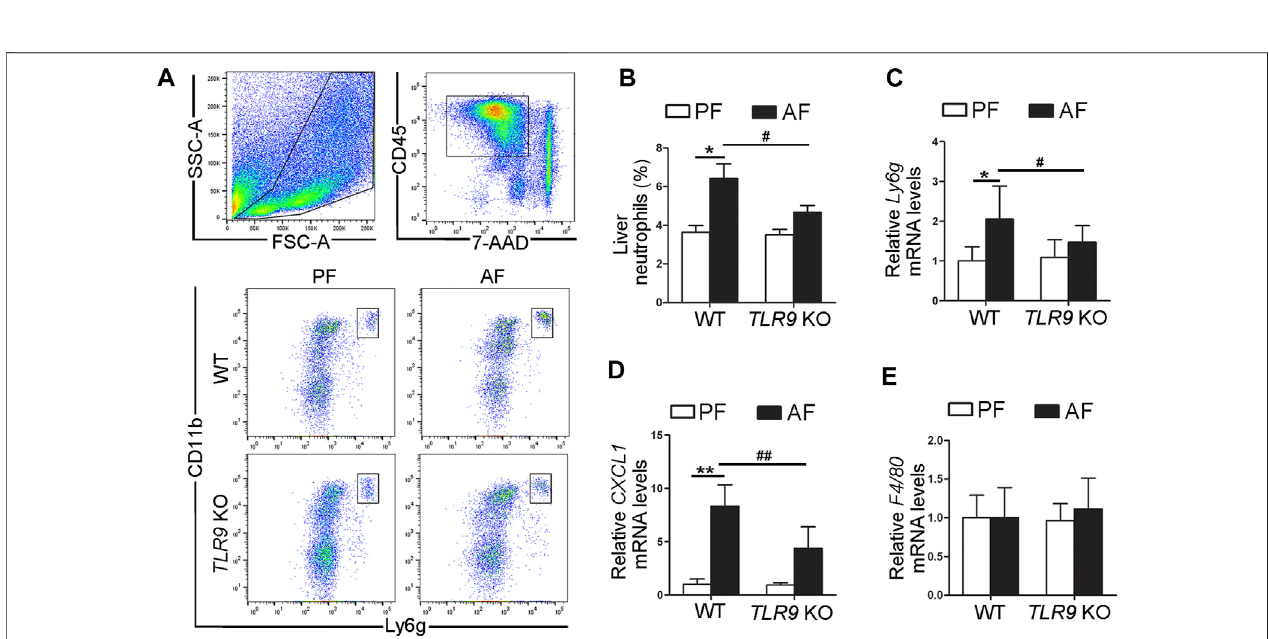
FIGURE 2 | TLR9 deletion ameliorates alcohol-induced proin fl ammatory response in the liver. TLR9 KO and wild-type male mice were pair-fed or alcohol-fed for 8 weeksplusasinglebingeofethanol(4 g/kg)before4 hoftissuecollection. (A) Gatingstrategyofneutrophilsin fi ltrationintheliver. (B) Bargraphofliverneutrophils. (C) Bar graphofhepatic Ly6g mRNAlevels. (D) Bargraphofhepatic CXCL1 mRNAlevels. (E) Bargraphofhepatic F4/80mRNAlevels. Dataarepresented asmeans ± SD. * p < 0.05, ** p < 0.01 vs. WT/PF mice; # p < 0.05, ## p < 0.01 vs. WT/AF mice. PF, pair-fed; AF, alcohol-fed.